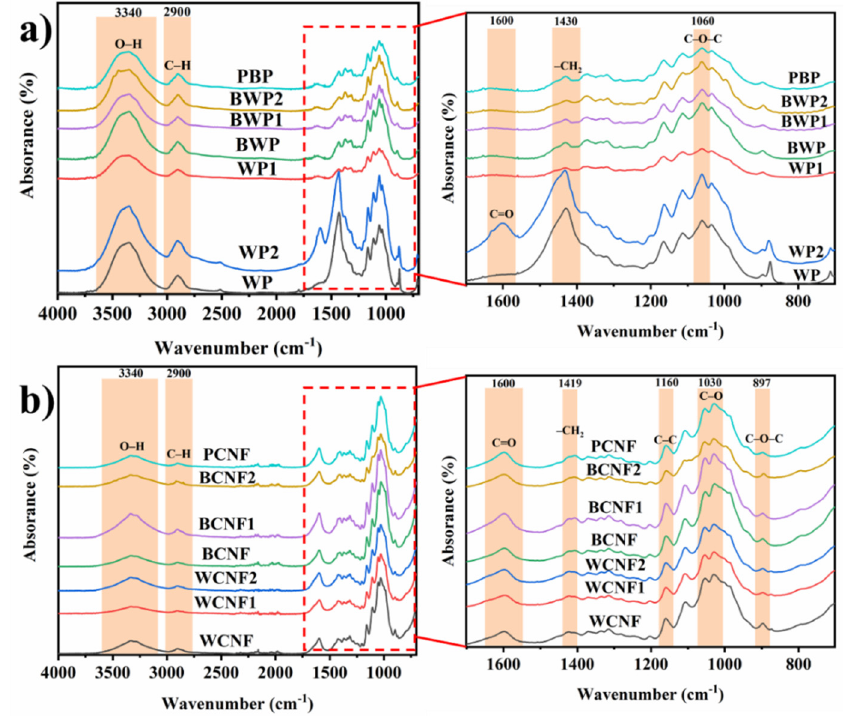
Figure 4. FTIR spectra of all samples before and after TEMPO oxidation. ( a ) Fiber sample before TEMPO oxidation, ( b ) CNFs sample after TEMPO oxidation.